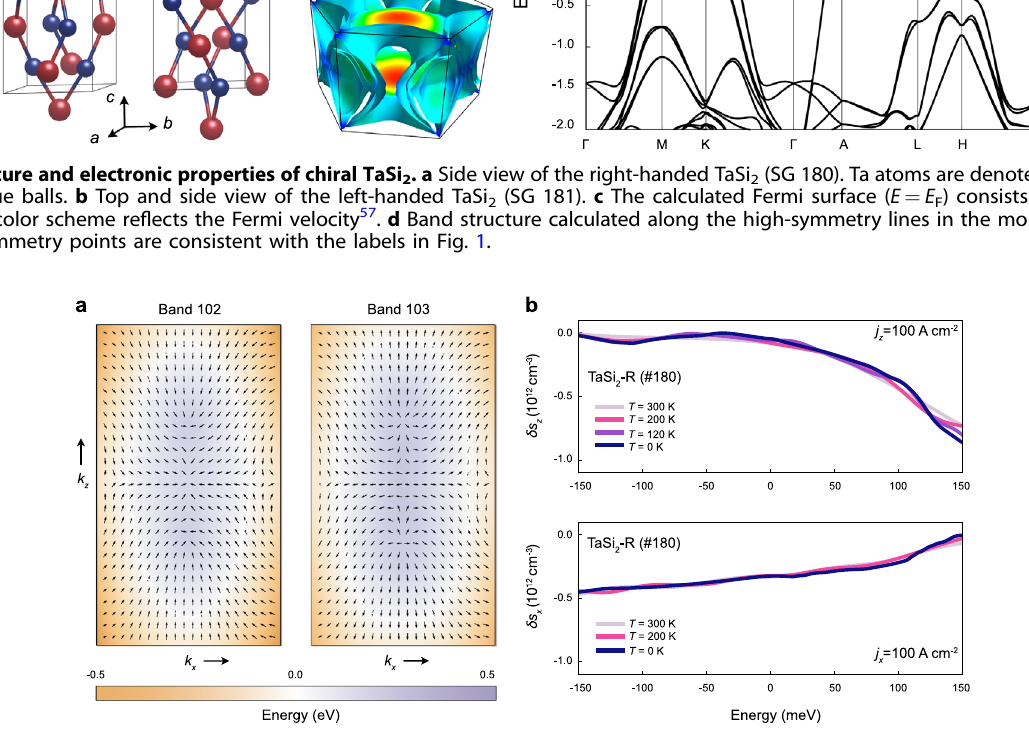
Fig. 4 Spin texture and spin accumulation in the right-handed TaSi 2 (SG 180). a Energy eigenvalues and spin texture of the two innermost bands visible in Fig. 3e projected on the k x − k z plane passing through the K point; the K point is located exactly at the center. The S y components are included only in the norms of the spin vectors. The multiple arrows serve as a better illustration of the trend, but only those coinciding with the Fermi contour — denoted as the white line — contribute to the spin accumulation. b The calculated spin accumulation vs energy; the components δ s z and δ s x are shown in the upper and bottom panels, respectively. The omitted δ s y is similar to δ s x . The colors of the lines correspond to different